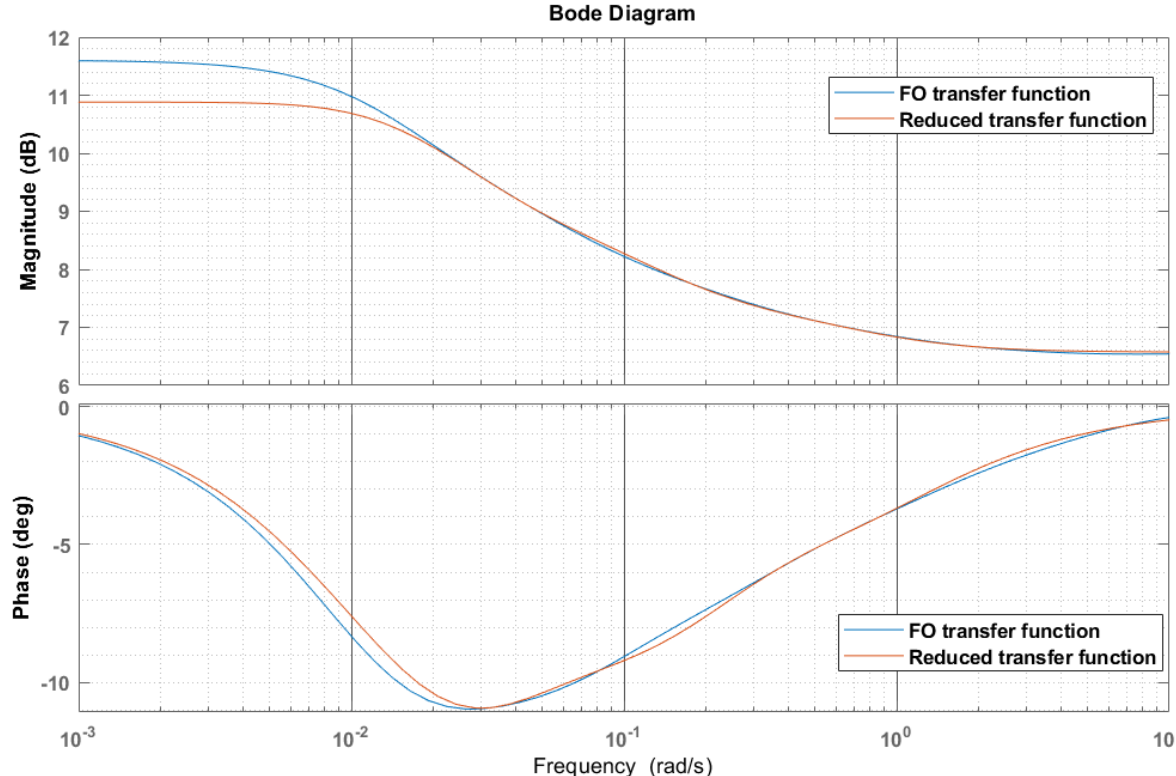
Figure 2. Bode plot for FO and reduced FO transfer function of controller for Link